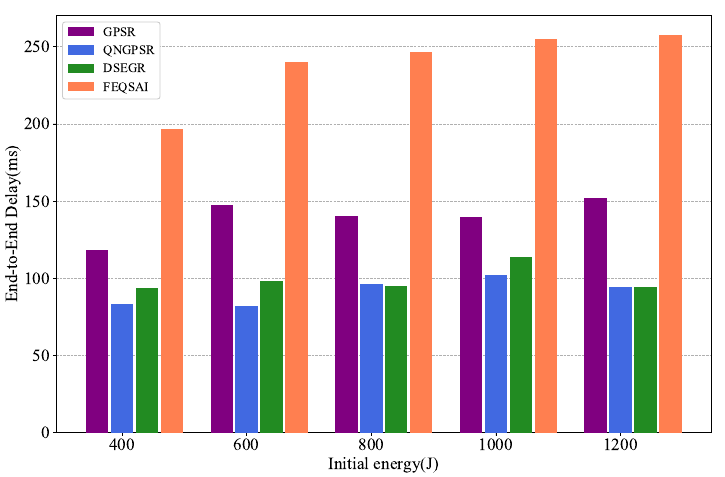
Figure 14. Performance comparison of the time of the first dead node among GPSR, QNGPSR, DSEGR, and FEQSAI with different initial packet energy.